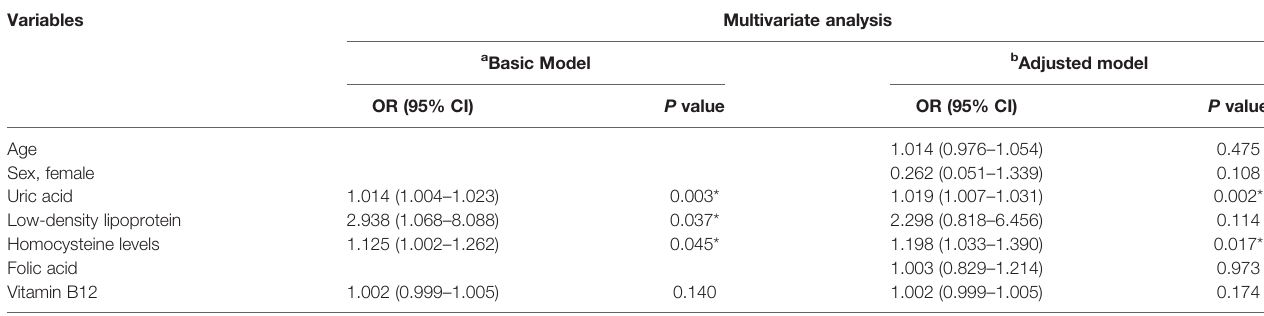
TABLE 7 | Multivariate logistic regression analysis of predictive factors for the severity at the onset of myelin oligodendrocyte glycoprotein antibody disease.